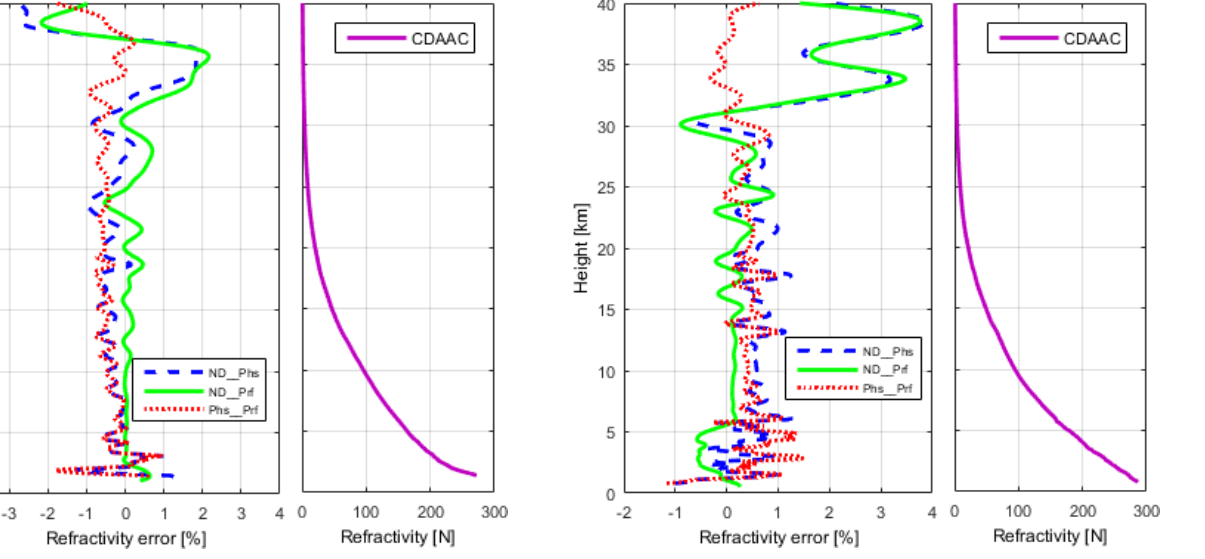
Figure 1. The results of ND_Phs, ND_Prf and Phs_Prf in the set- ting radio occultation. ND_Phs expresses the relative refractivity offset between Ref_ND and Ref_Phs; ND_Prf denotes the relative refractivity offset between Ref_ND and atmPrf; Phs_Prf indicates the relative refractivity offset between Ref_Phs and atmPrf prod- ucts; Ref_ND is the refractivity obtained from ND-derived AEP based on ROPP software; Ref_Phs is the refractivity obtained from atmPhs profiles based on ROPP software.